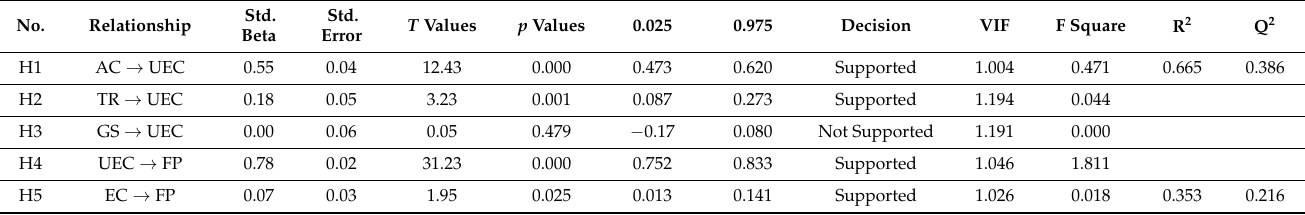
Table 5. Hypothesis testing results (direct effect).